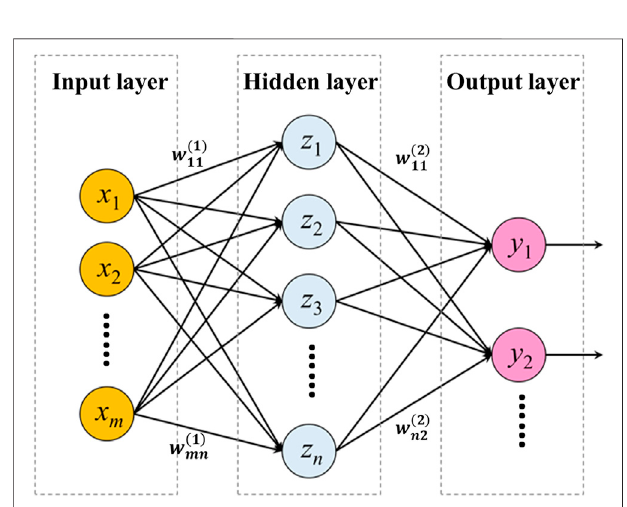
FIGURE 16 | Schematic diagram of the basic BP neural network